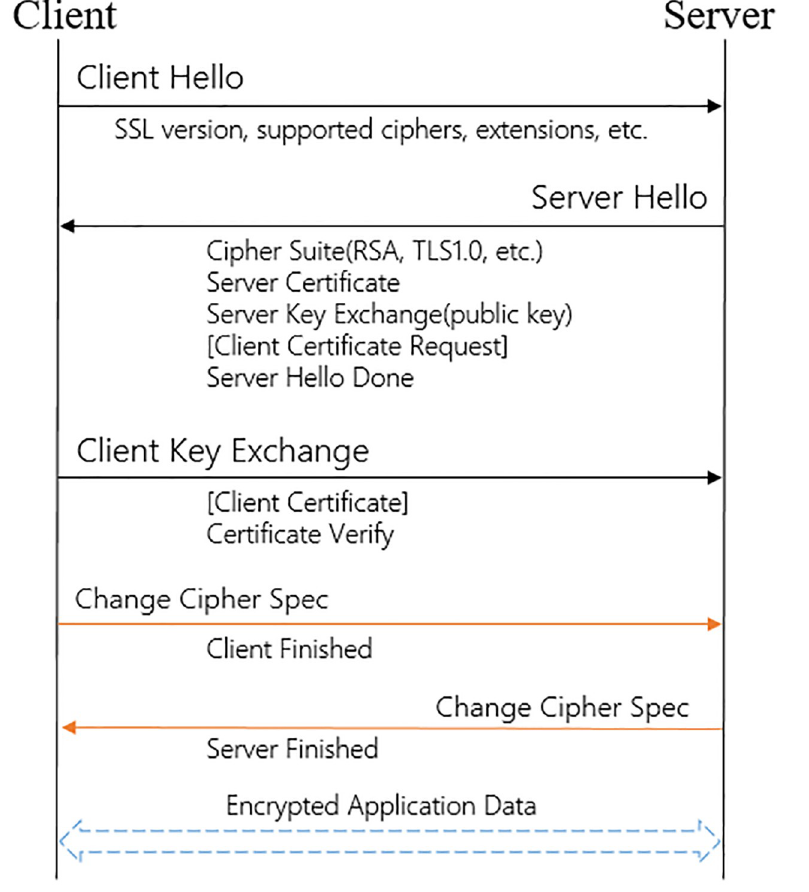
Fig 2. TLS protocol key negotiation